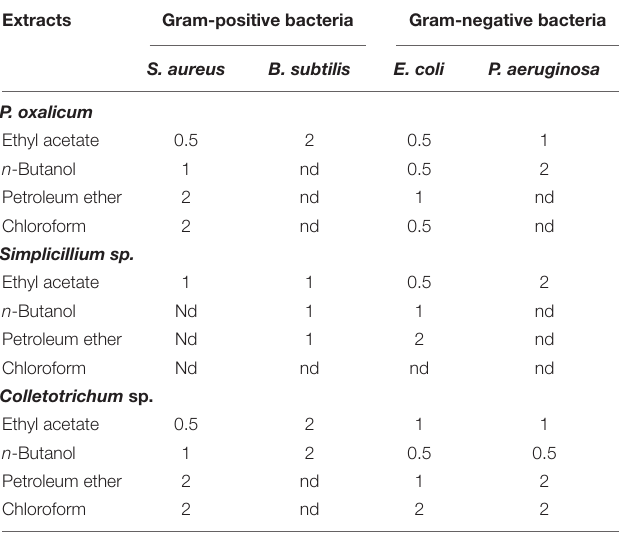
TABLE 4 | Minimum inhibitory concentration (MIC) (mg/mL) of the P . oxalicum , Simplicillium sp., and Colletotrichum sp. extracts. Extracts